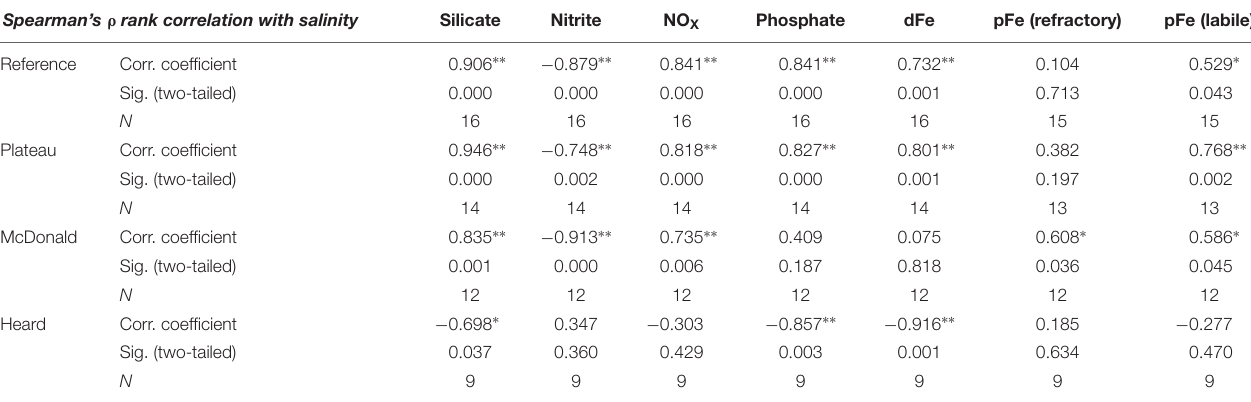
TABLE 5 | Spearman’s ρ rank correlation coefficients, significance, and the number of independent data points used for each measurement for various parameters correlated with salinity. Spearman’s ρ rank correlation with salinity Silicate Nitrite